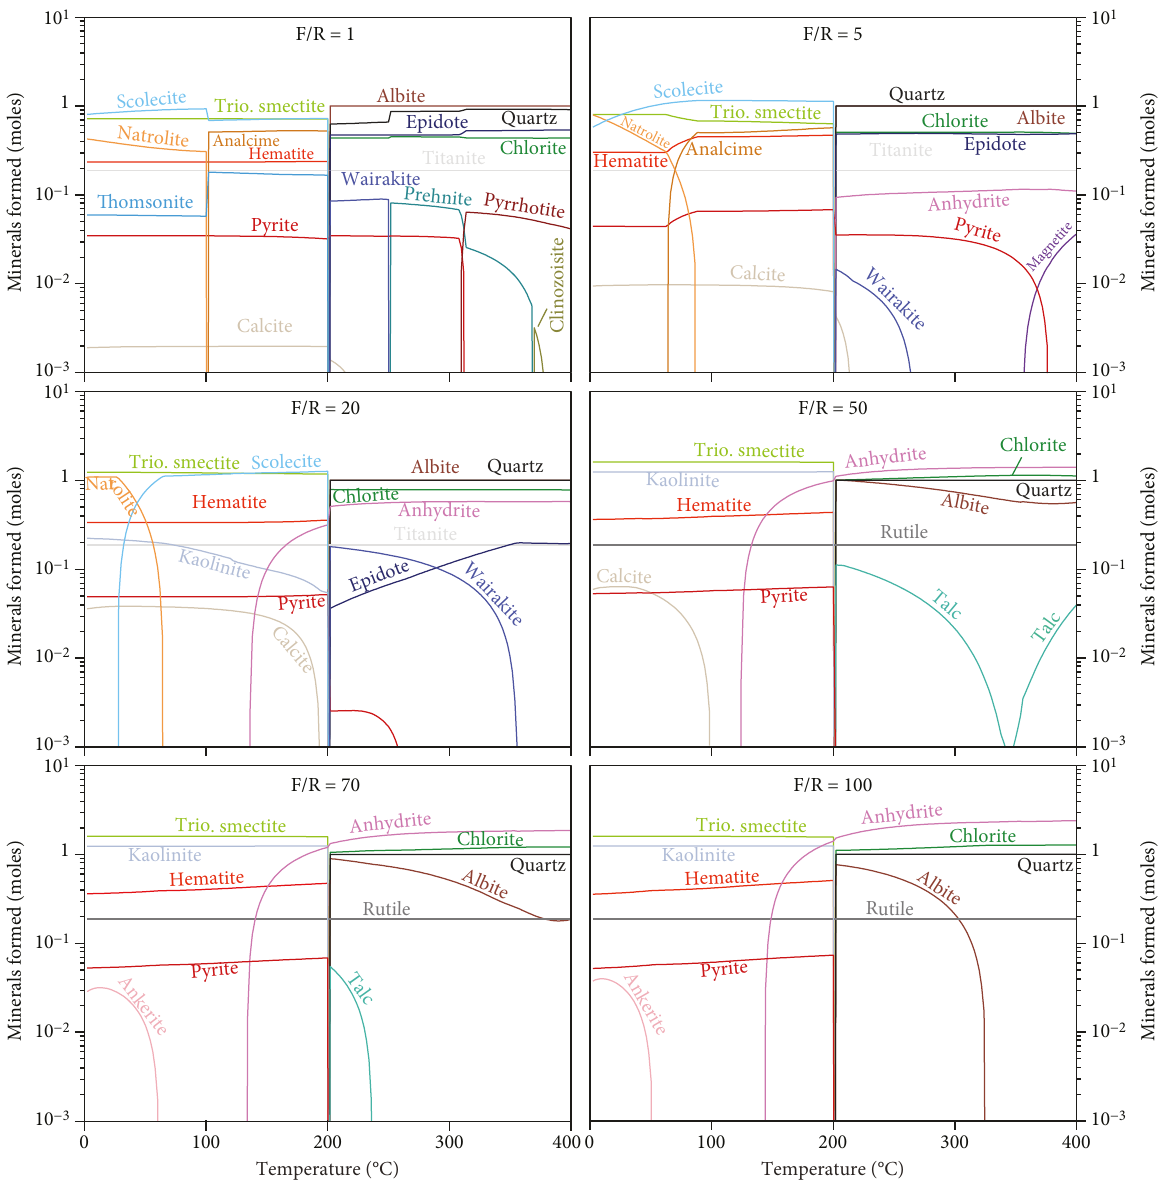
Figure 2: Simulated stable mineralogy (in moles) formed during seawater-basalt interaction from 2 to 400 ° C, 500 bars, and variable fl uid/rock (F/R) mass ratios representative of conditions documented at mid-ocean